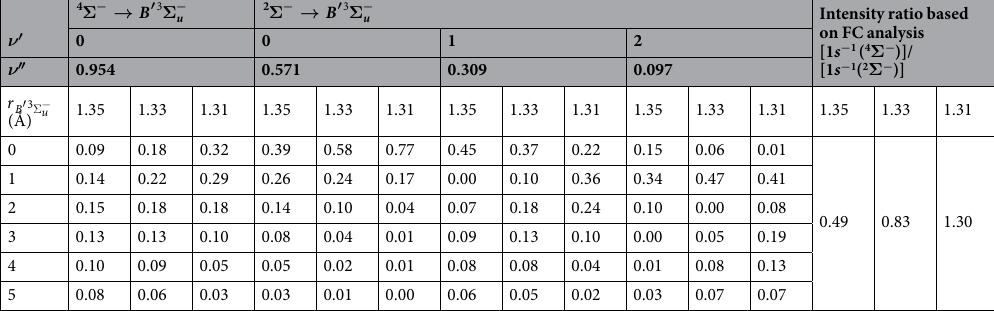
with 2.18 ratio in the photoionization